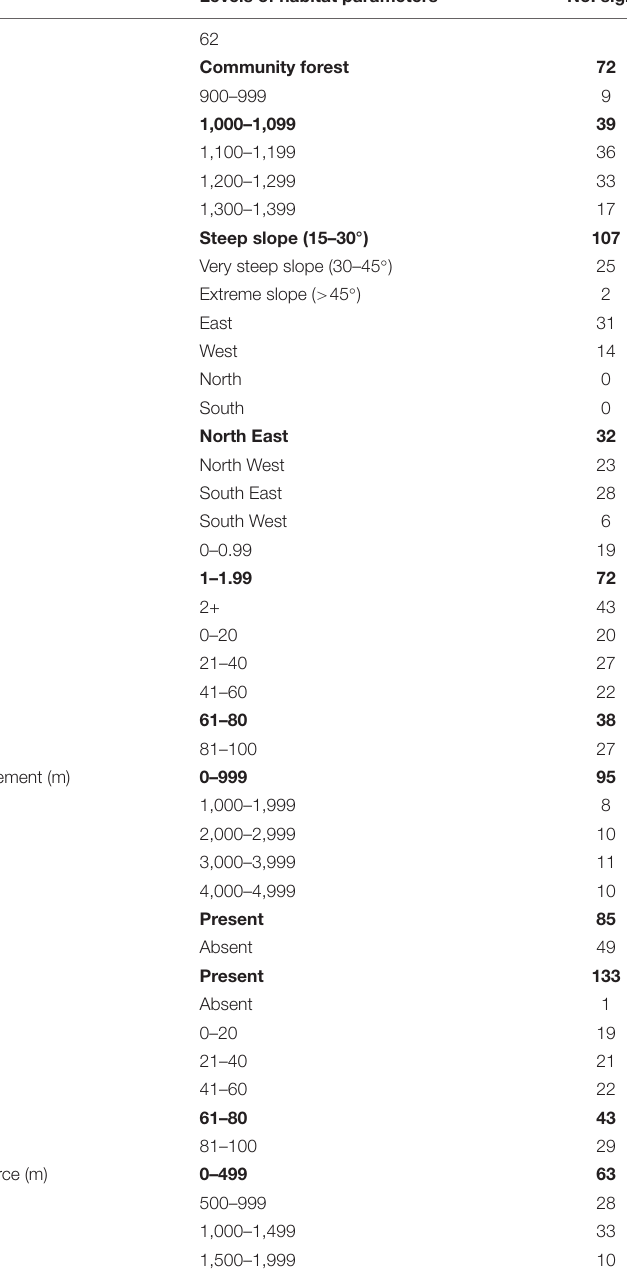
TABLE 1 | Numbers of direct and indirect signs of barking deer presence for the 11 habitat parameters measured; data from both study areas are lumped; for each habitat parameter the most often recorded parameter levels are in boldface. Habitat parameters Levels of habitat parameters No.